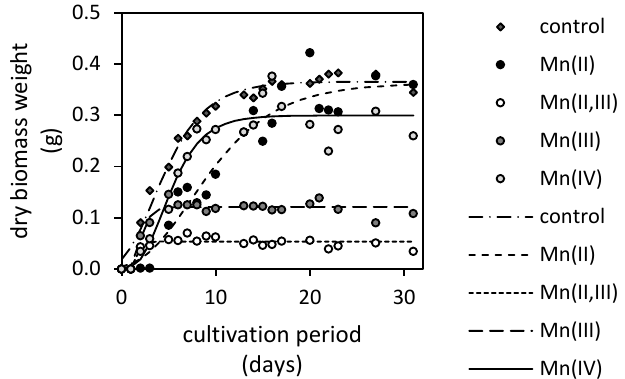
Figure 2. Changes in biomass weight of Aspergillus niger cultivated for 31 days in the culture medium supplemented with various manganese oxides (MnO, MnO · Mn 2 O 3 , Mn 2 O 3 and MnO 2 ; control is a manganese-free treatment). Experimental data were fitted using modified Gompertz’s equation [15].